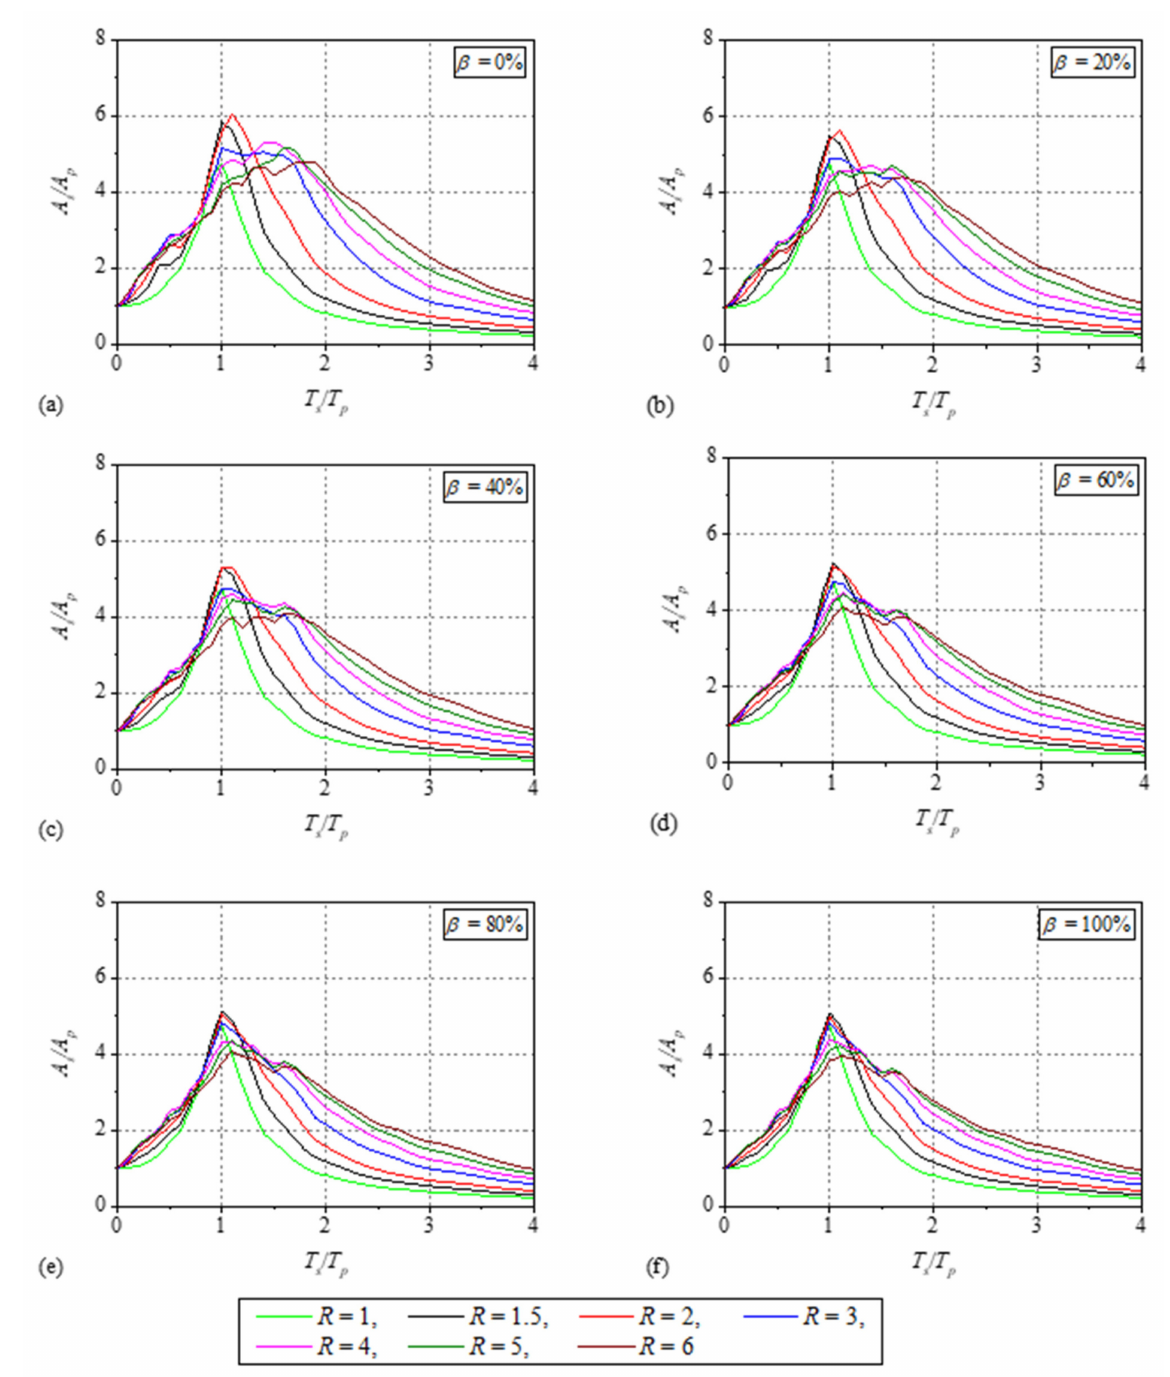
Figure 3. Mean normalized floor response spectra for SC systems with T p = 1.0 s, post-yield stiffness ratio α = 5%; viscous damping ratio ξ p = 5%; and a secondary structure with viscous damping ratio ξ s = 5%: ( a ) β = 0%; ( b ) β = 20%; ( c ) β = 40%; ( d ) β = 60%; ( e ) β = 80%; and ( f ) β =